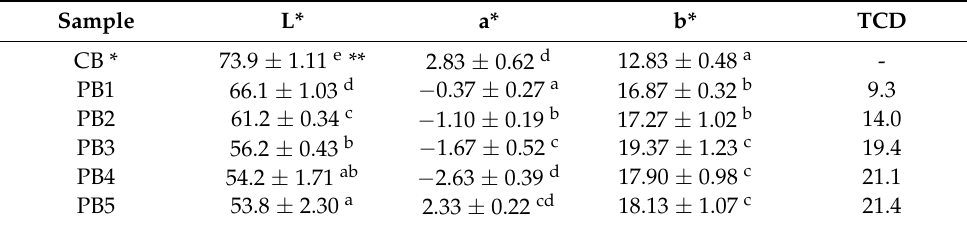
Table 2. Color coordinates and total color difference (TCD) of the crumb.